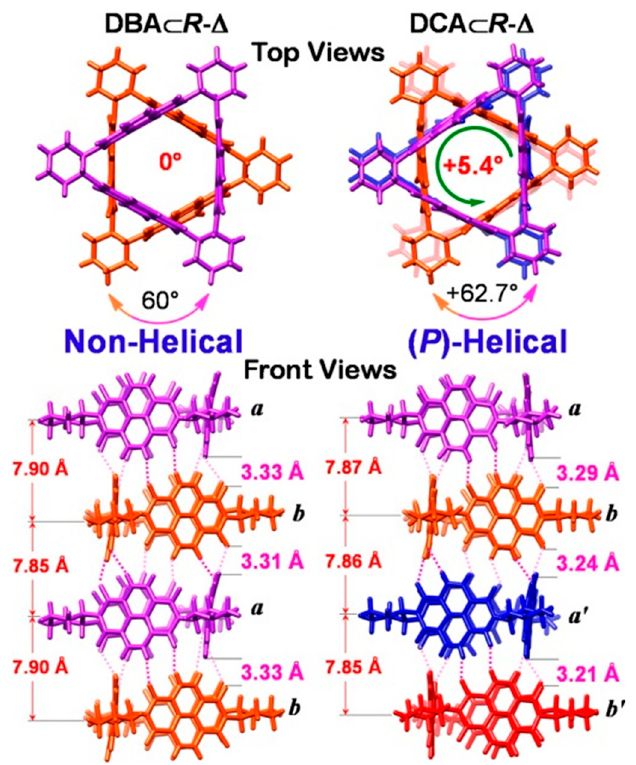
Figure 5. Comparison of single-crystal X-ray superstructures: nonhelical tetrameric unit of DBA& R - ∆ (on left) and ( P )-helical tetrameric DCA& R - ∆ (on right). Reproduced with permission from Ref. [45] (Copyright American Chemical Society, 2014).